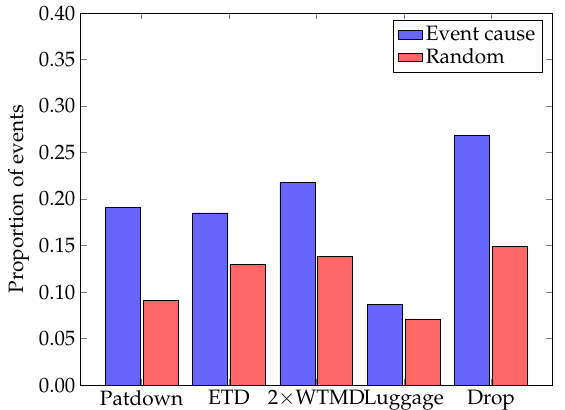
Figure 10. The proportion of events that were preceded by a potential cause, compared to the total frequency of these events in the dataset. Luggage refers to passengers that receive a luggage